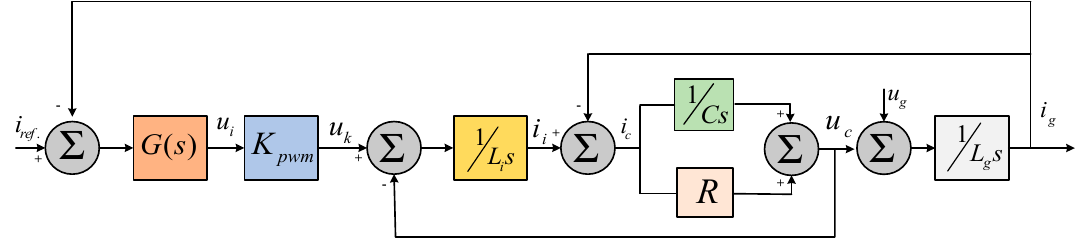
Figure 16. One-leg block diagram of a passive damping control strategy for a grid-connected VSI.